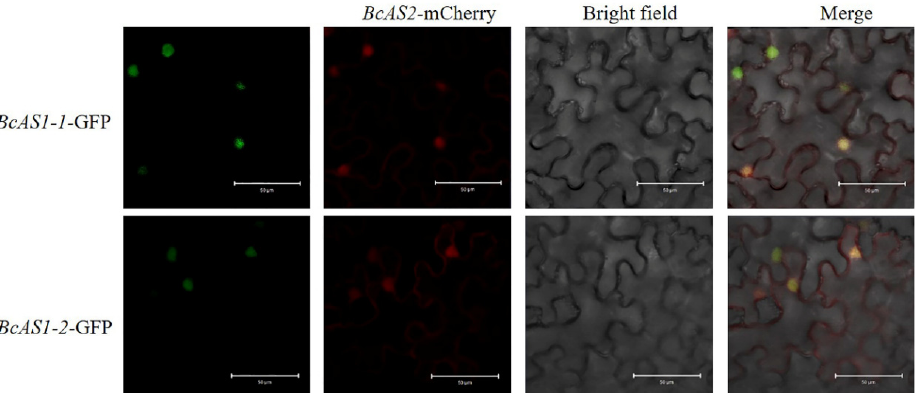
Figure 5. The BcAS2 -mCherry and BcAS1-1/2 -GFP were co-localized in the nucleus. From left to right, the fluorescence signals in the nucleus, nucleus, and cytomembrane, nucleus due to BcAS1-1/2- GFP, BcAS2- mChery and the co-expression between them, respectively. Scale bars = 50 μ M.